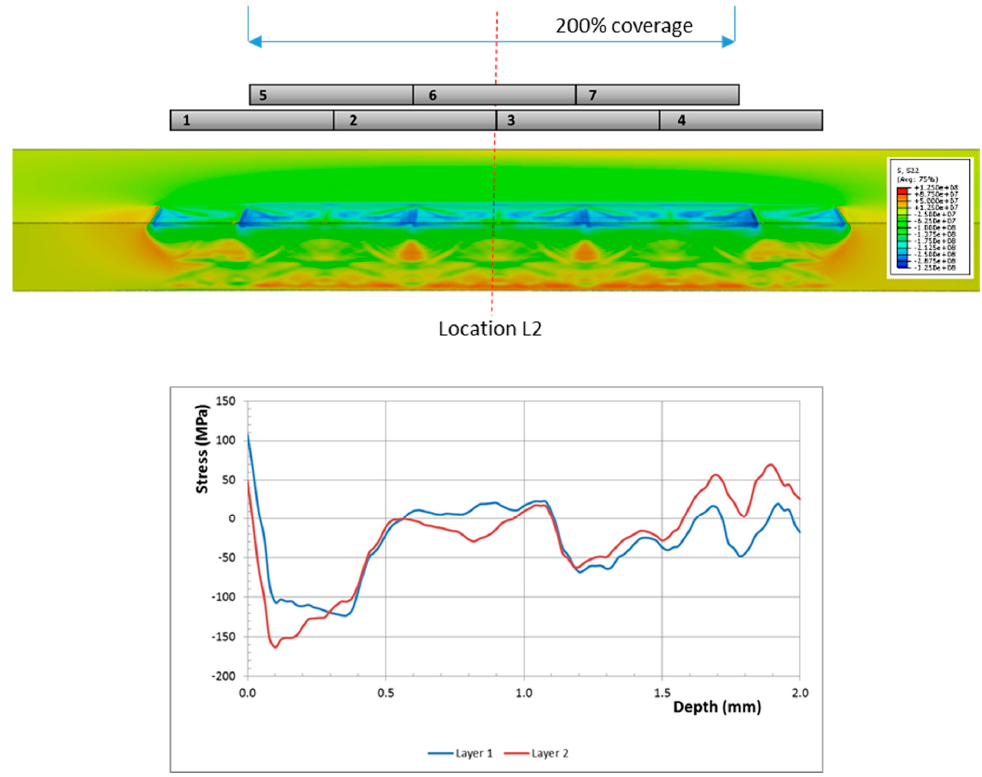
Figure 9. Effect of peen layering on predicted in-plane residual stress in thin sections. Stresses were extracted from the FEA model at Location L2 after one and two layers of peening.